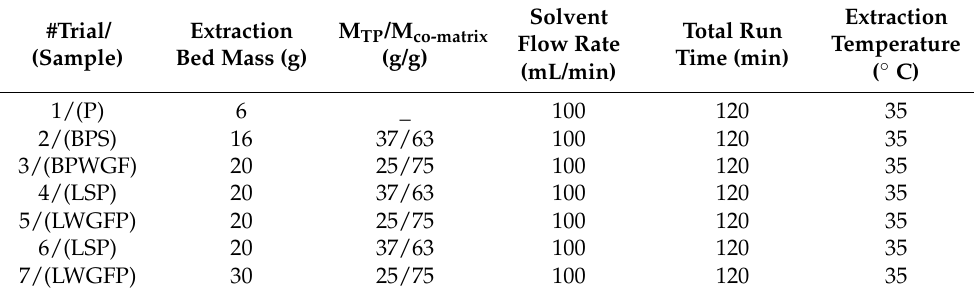
Table 1. Process conditions used during the extraction tests carried out by Norflurane